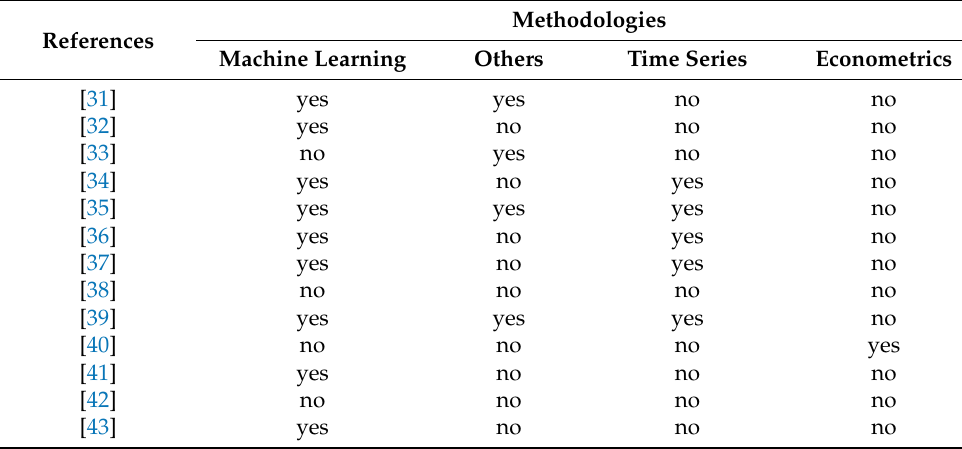
Table 3. Families of methodologies employed in the papers under analysis.